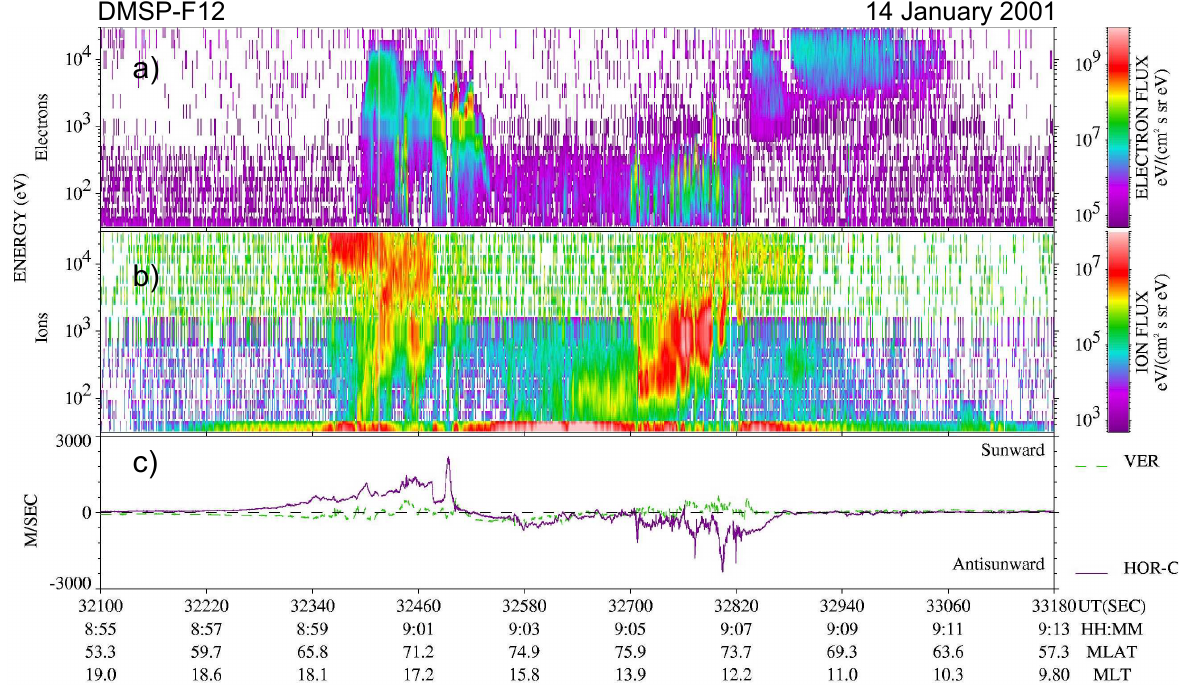
Fig. 4. Energy-time spectrograms for (a) electrons and (b) ions observed by DMSP-F12 as it passed equatorward along the path given in Fig. 1. In both cases, the differential energy flux is plotted as a function of energy (increasing upward) and observation time, t s . (c) shows the vertical (green) and horizontal (purple) components of the ion velocity (the horizontal component is perpendicular to the satellite track such that positive values have a sunward component and negative values an anti-sunward